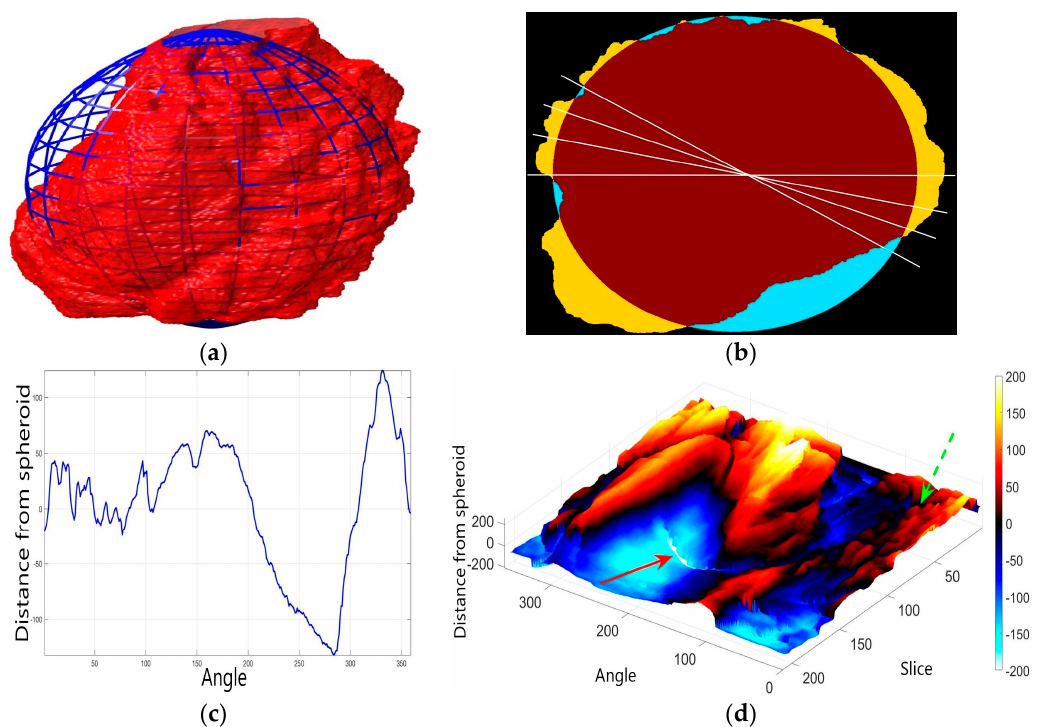
Figure 7. Nuclear envelope (NE) surface modelling against a spheroid. ( a ) Rendering of the nuclear envelope (NE) (red surface) against the model spheroid (blue mesh). ( b ) Illustration of distance calculations by ray tracing in one slice. Yellow regions correspond to the nucleus outside the spheroid, cyan regions to nucleus inside the spheroid. ( c ) Measurements obtained along the boundary. ( d ) Surface corresponding to the distance from the NE to a model spheroid. Solid red arrow indicates a notch, dashed green arrow shows rugged region.